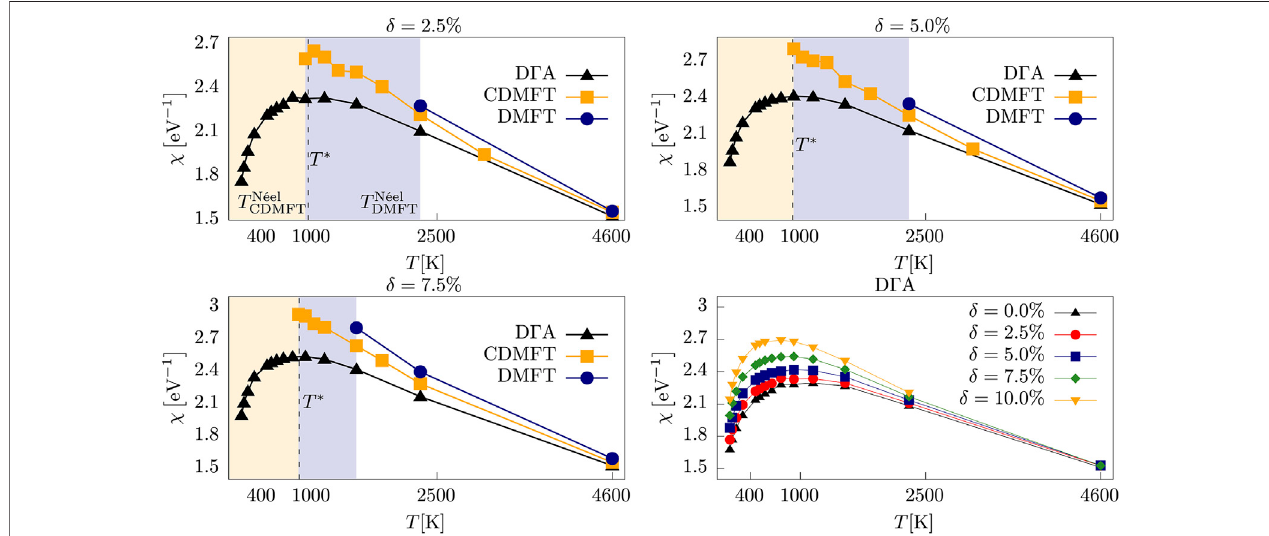
FIGURE 2 | Static uniform magnetic susceptibilities χ as a function of T for 2.5% (upper left panel), 5% (upper right panel) and 7.5% (lower left panel) hole doping. The transition temperature of DMFT T Néel DMFT is indicated in blue and the DMFT-ordered regime in blue shadings (for CDMFT T Néel CDMFT in orange). The lower right panel summarizes χ from D Γ A for different hole